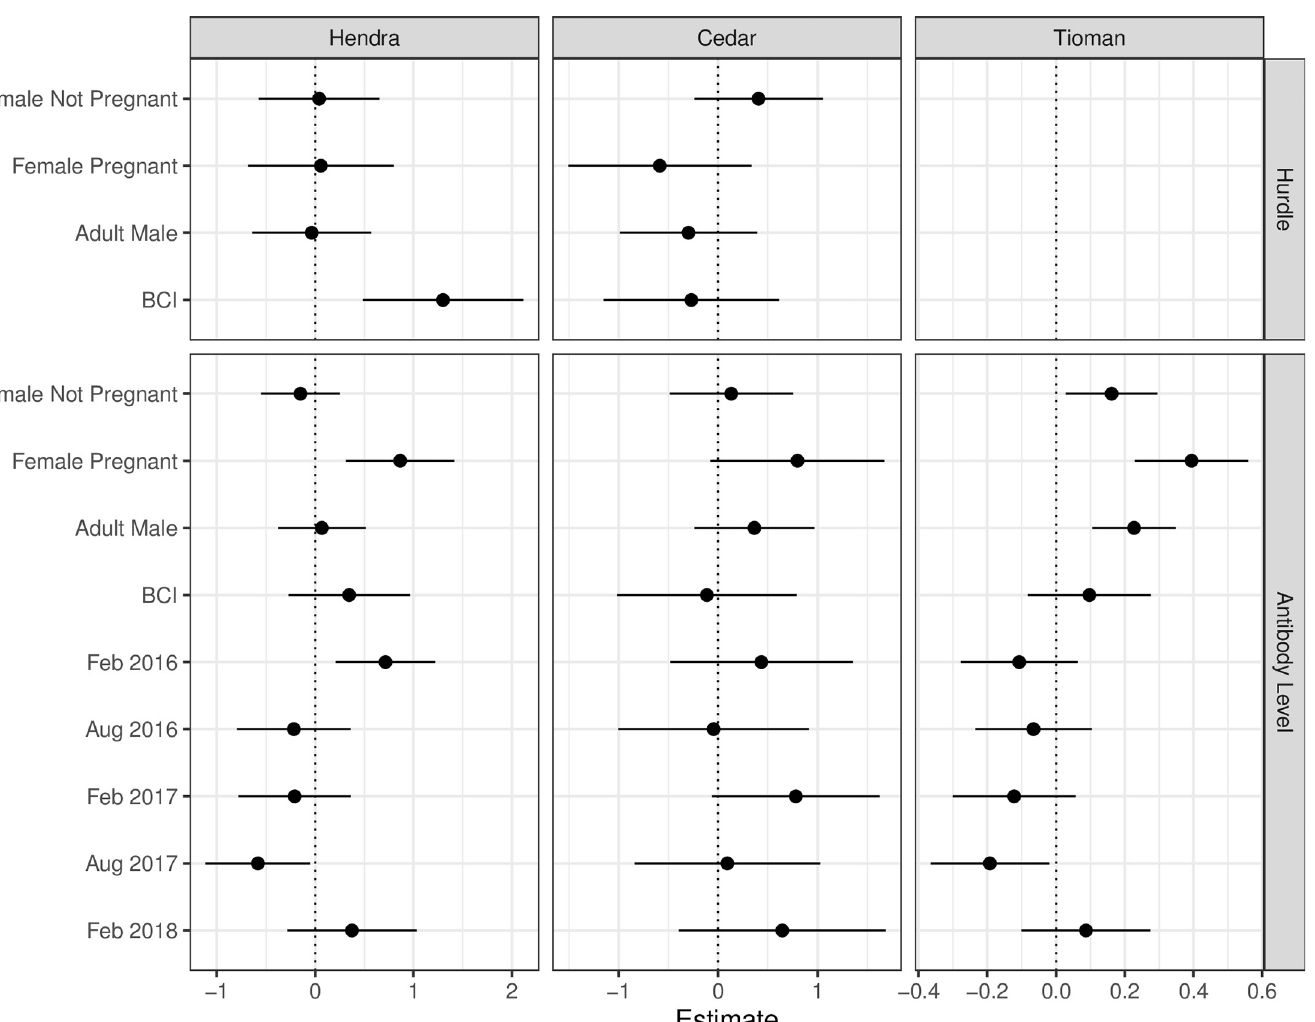
Fig 3. Effect plots for hurdle and antibody level models. Effect plots for the estimates and P values for negative binomial hurdle and antibody level models for Hendra virus, Cedar virus and Tioman virus serology for Grey-headed flying foxes sampled between August 2015 and February 2018.